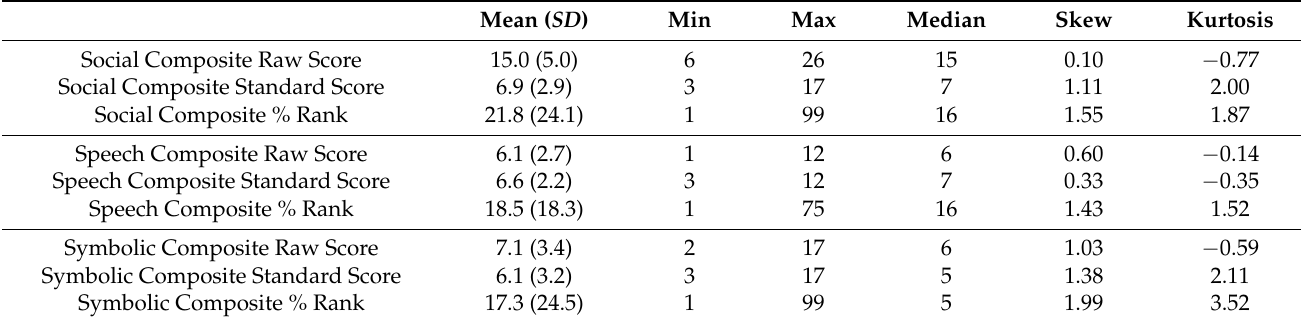
Table 4. Score distributions of the Communication and Symbolic Behavior Scales Infant Toddler Checklist (CSBS-ITC) at Time 2.